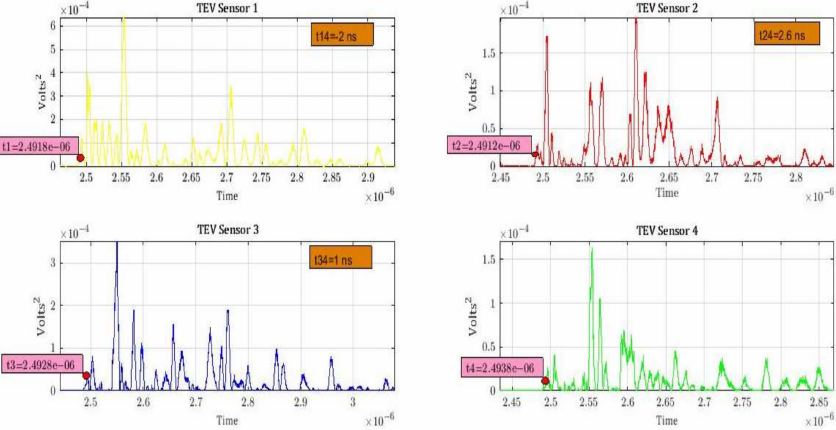
Figure 6. Plot of V 2 against time for (4 TEV) sensors for PD source at location 9. Figure 6 . Plot of 𝑉 (cid:2870) against time for (4 TEV) sensors for PD source at location 9.